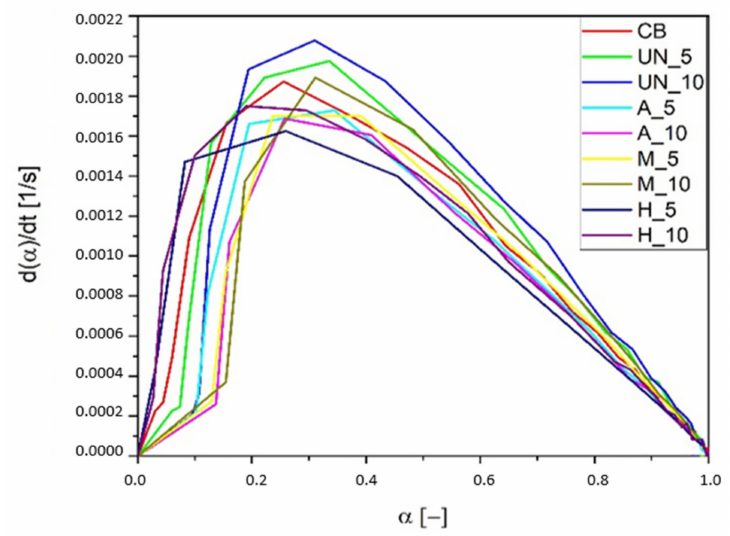
Figure 8. Vulcanization speed of the rubber mixes containing various amounts of GTRs modified in different ways in function of the vulcanization degree.